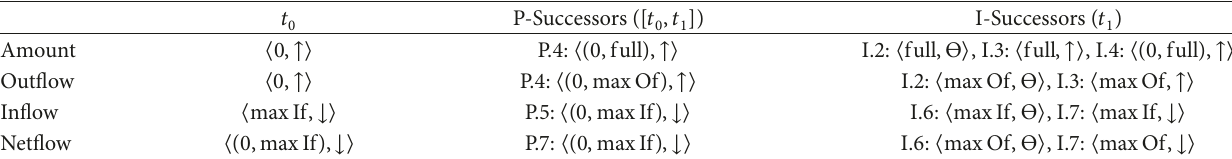
Table 5: Qualitative behavior